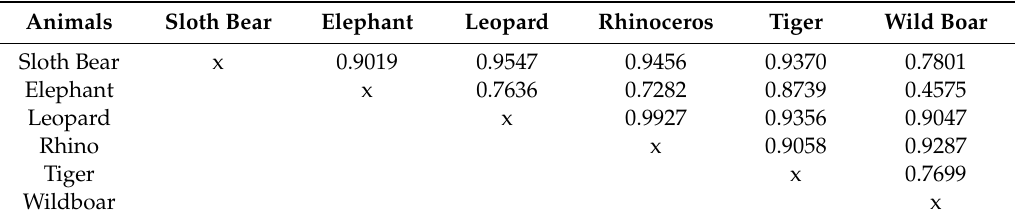
Table 1. Pearson’s coe ffi cient of correlation between percentage of specific land use mosaics